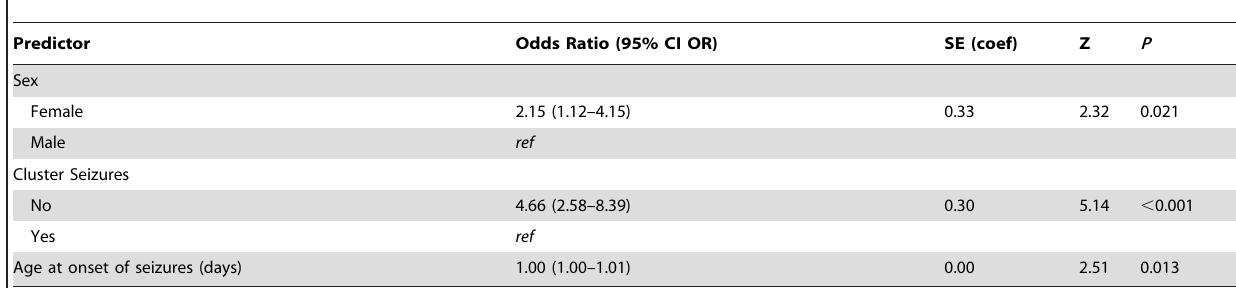
Table 4. Risk factors for an $ 50% reduction in seizure frequency in canine epilepsy cases.